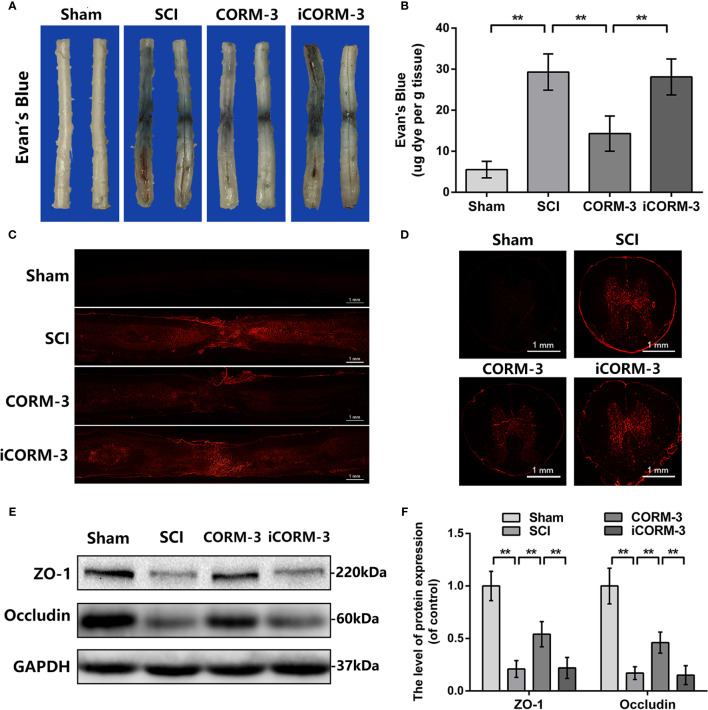
Carbon monoxide inhibits BSCB interruption and declined TJ proteins at 3 days following SCI. (A) Characteristic complete spinal cords show that Evan's Blue dye infused into spinal cord at 3 days. (B) Quantifying the Evan's Blue at 3 days (μg/g). (C, D) Characteristic fluorescent images of Evans Blue Dye extravasation at 3 days. (bars: 1 mm). (E, F) The protein expression of ZO-1 and Occludin in spinal cord at 3 days post-SCI. All data is denoted as mean ± S.D. (n = 5). **P < 0.01.